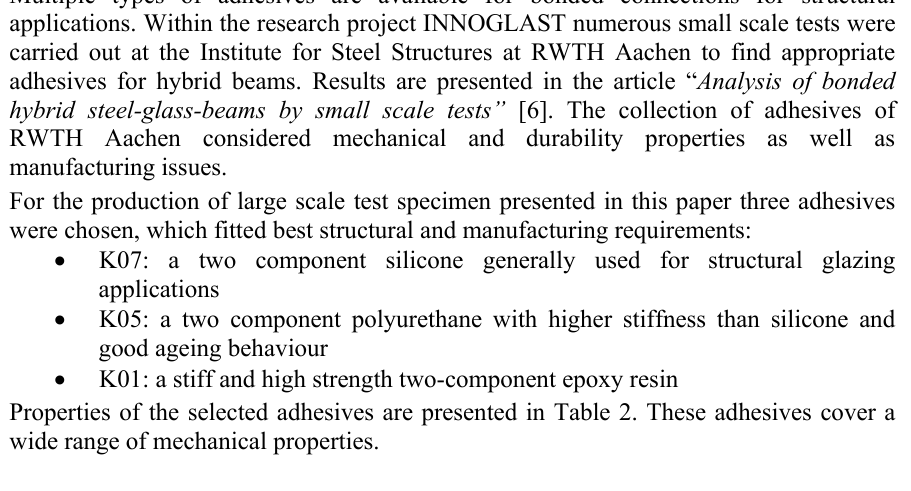
Table 2: Properties of adhesives for large scale tests (average values) Adhesive